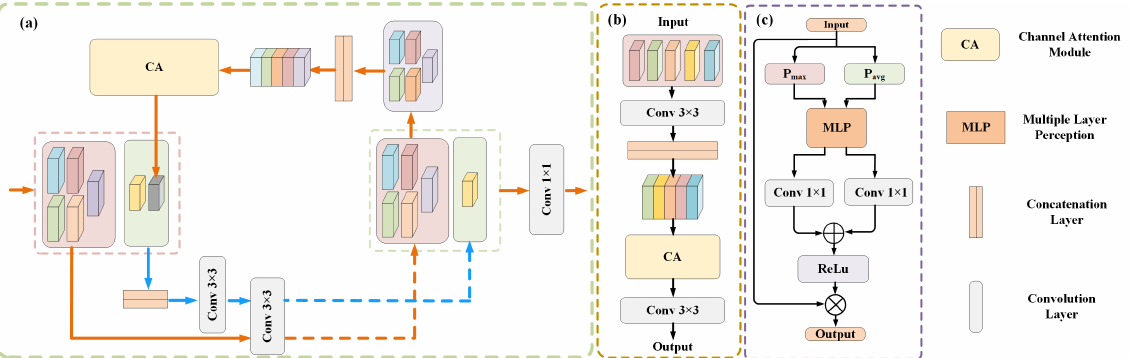
Figure 5. Details of the associated information fusion module and the associated information cor- rection network. ( a ) An associated information correction sub-network for correcting the global information following the semantic segmentation network. ( b ) The channel attention module used in the associated correction network and associated fusion module. ( c ) An associated information fusion module used to supplement global associated information between two-level